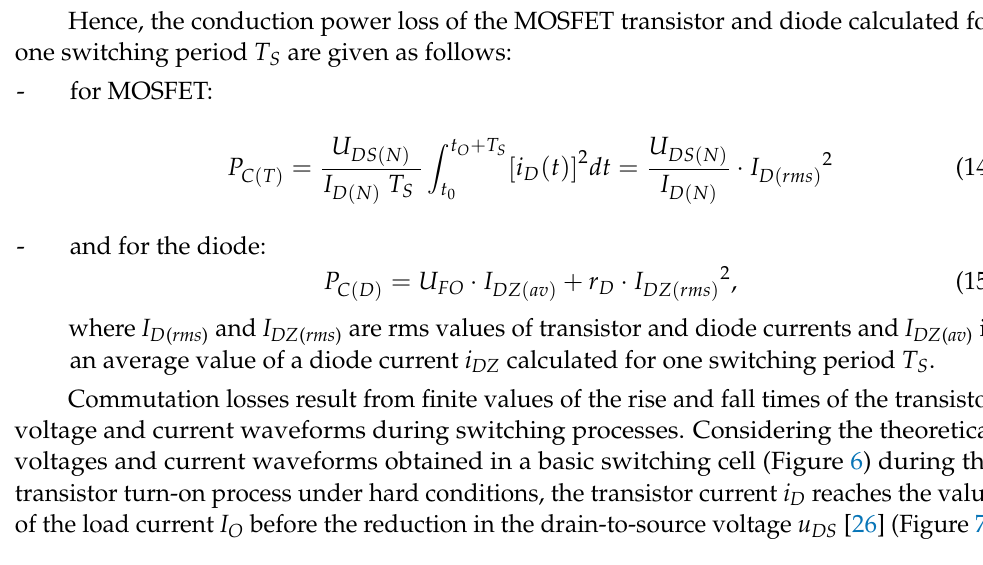
Figure 5. Linearization of the diode and MOSFET steady-state characteristics.